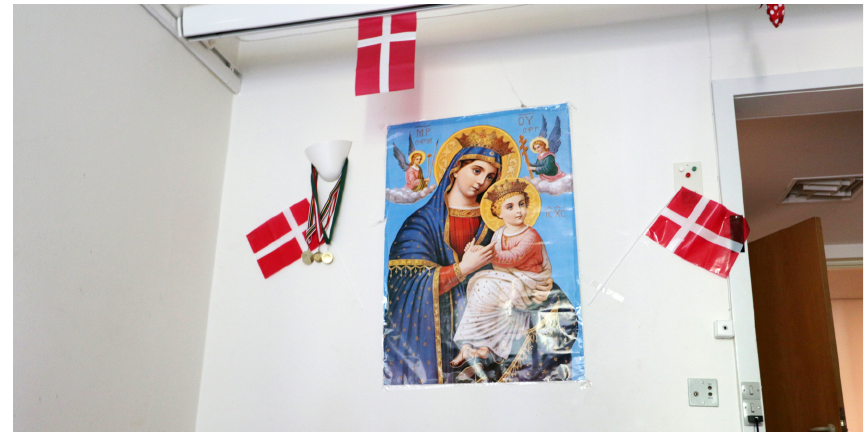
Figure 13. Poster of the Virgin Mary, Danish flags and football medals. April